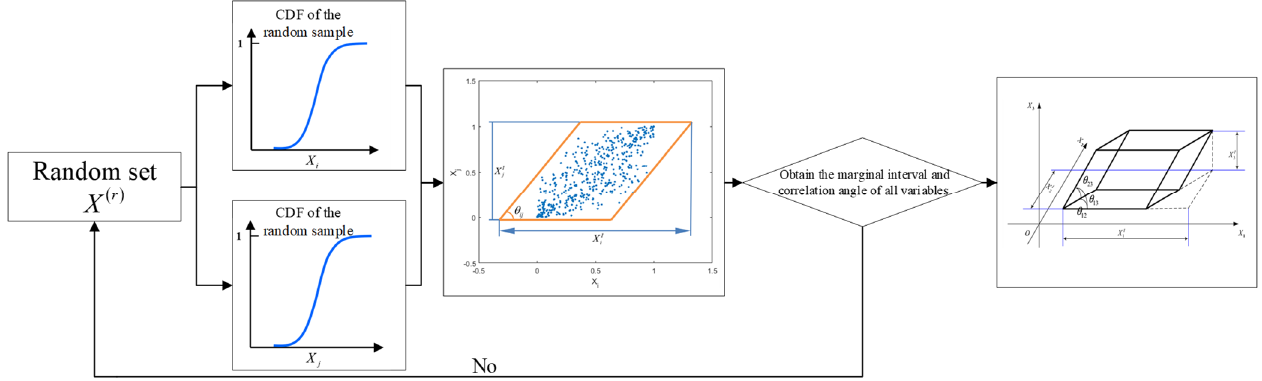
Figure 5. Flowchart for building the uncertainty domain.